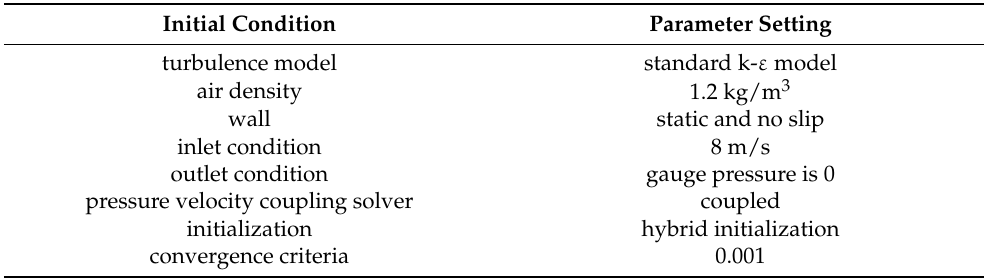
Table 7. Model initial